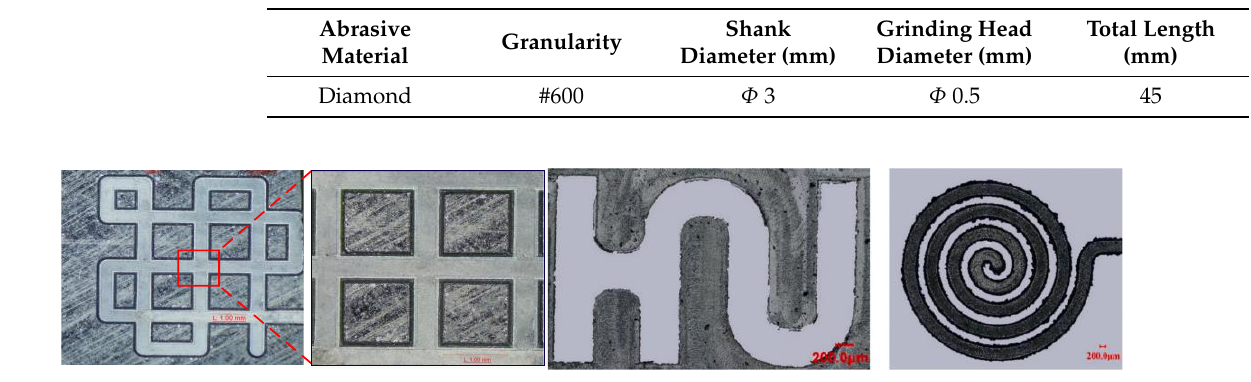
Figure 25. Micro-structure after micro-grinding.